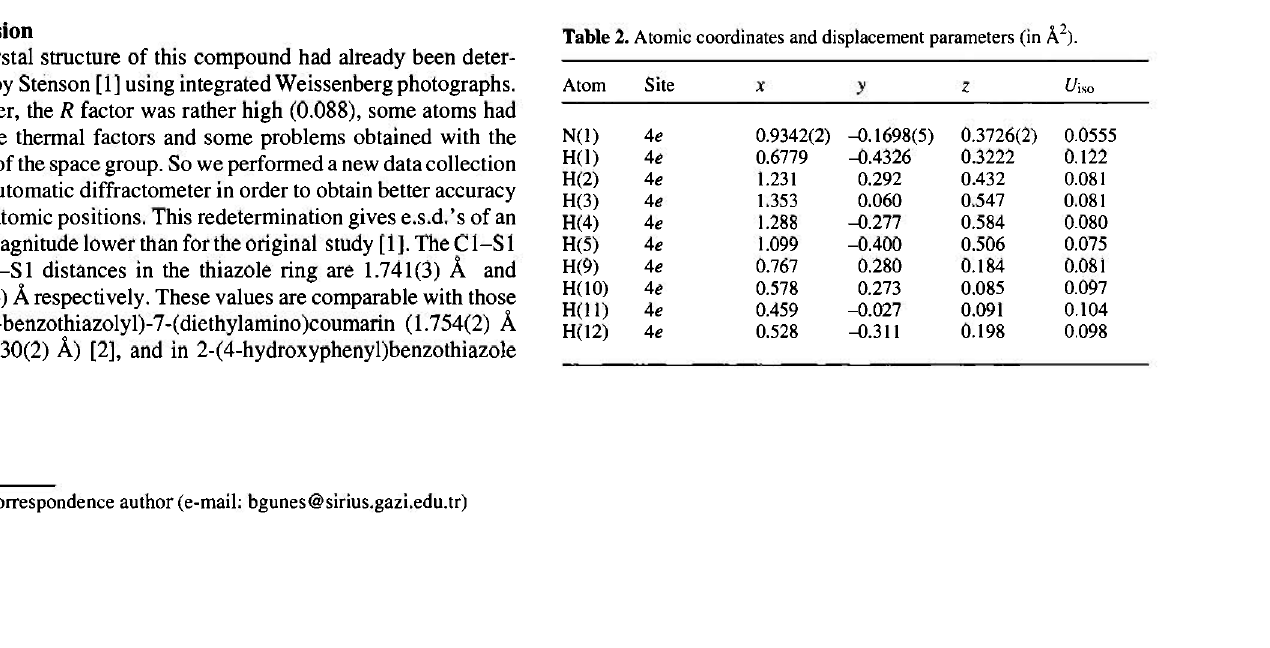
Table 1. Data collection and handling.